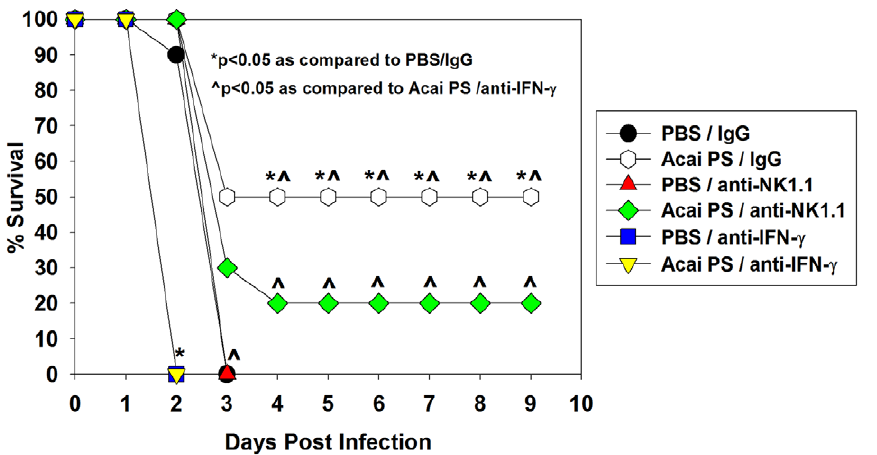
Figure 8. Acai PS requires IFN- c and NK cells for optimum protection against B.pseudomallei infection. Two days prior to infection, C57BL/6 mice received rat IgG, anti-IFN- c , or anti-NK1.1 mAb. Mice were treated i.n. with PBS (n=5–10/group) or 1 mg of Acai PS (n=10/group) one day prior to i.n. infection with 1 6 10 4 CFUs of B. pseudomallei 1026b. Survival was monitored over time. *P , 0.05 as compared to animals receiving PBS and IgG. ‘ P , 0.05 as compared to animals receiving Acai PS and anti-IFN- c